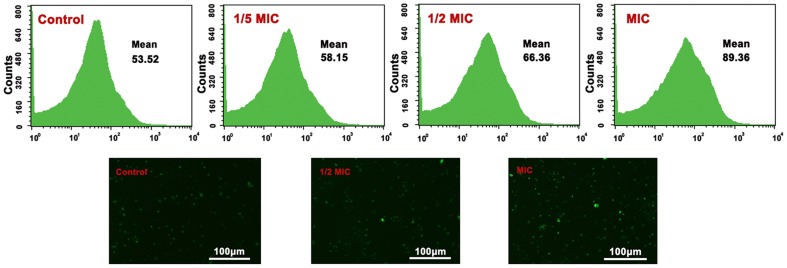
Cytosolic Ca2+ concentration in C. michiganense subsp. sepedonicum cells treated with Fractionation three.Analysis of Ca2+ concentration in C. michiganense subsp. sepedonicum cells by flow cytometry (upper panel) and fluorescence microscopy (lower panel, 10×). MIC, Minimum inhibitory concentration.